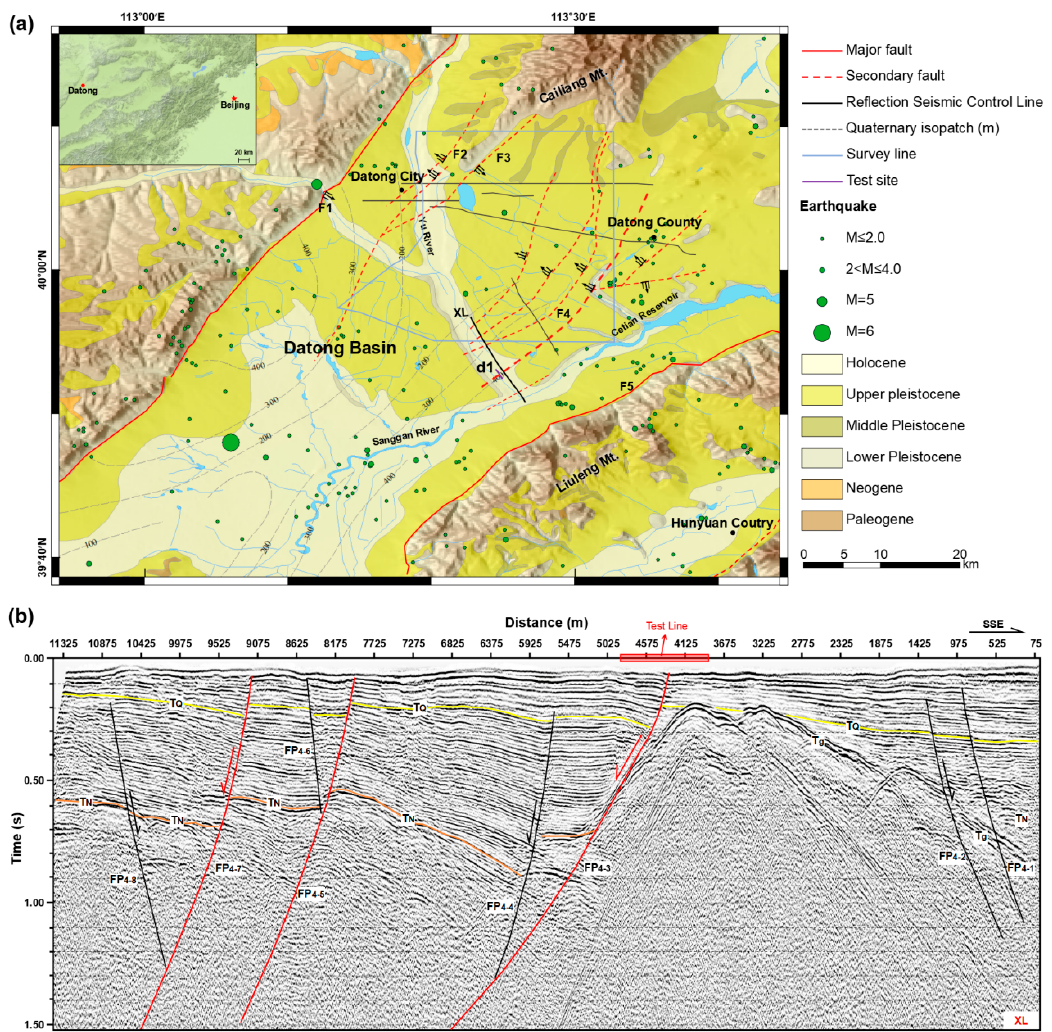
Figure 1. Geological maps of Datong basin. The active faults detected in this paper are marked as F4 with a bold red dashed line. The distributed optical fiber sensing at the Yu River site is denoted as the purple bar called d1 in ( a ) near line XL crossing fault F4, ( b ) shows the active seismic survey detection result of line XL, approximately 300 m to the south of line d1.